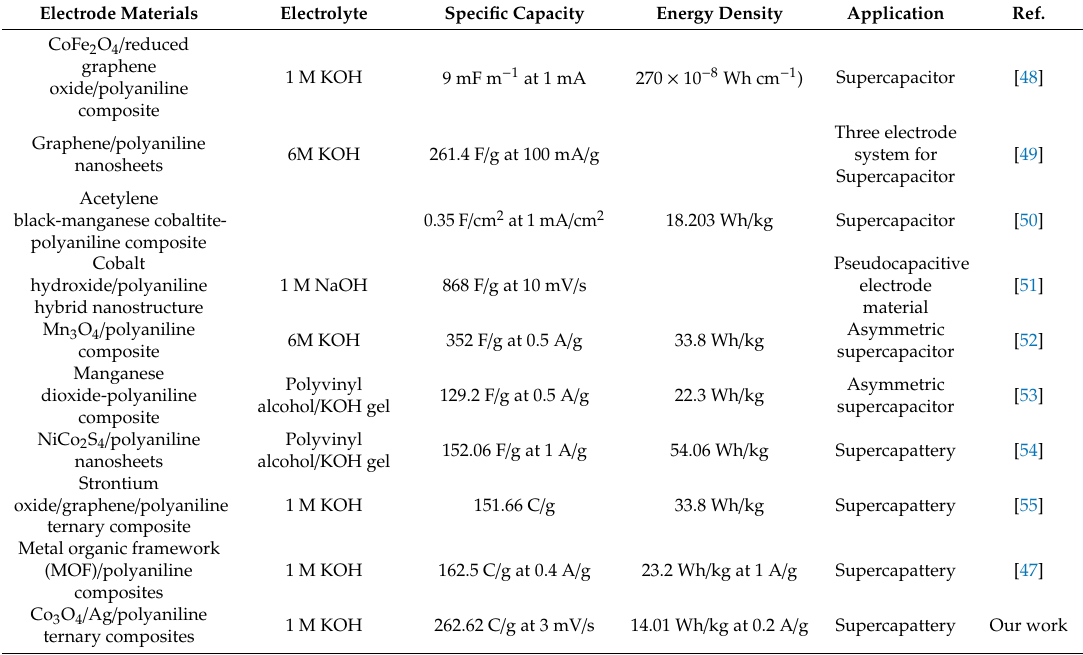
Table 2. Performance of PANI composite